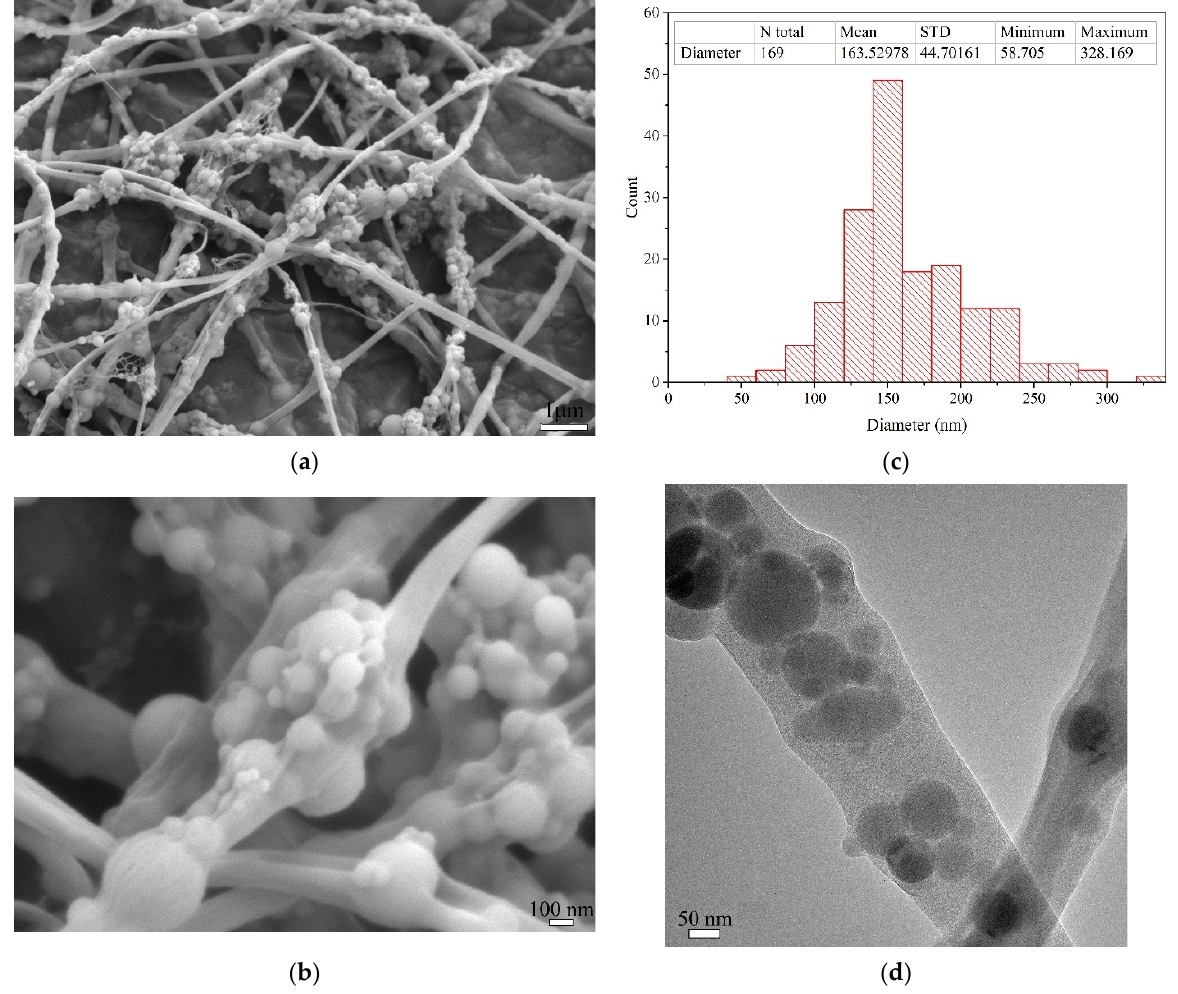
Figure 3. Morphological and microstructural characteristics of NS ‐ N66 NFs. ( a , b ) SEM images of NS ‐ N66 NFs at low and high magnification; ( c ) Diameter statistic; ( d ) TEM image of NS ‐ N66 NFs.